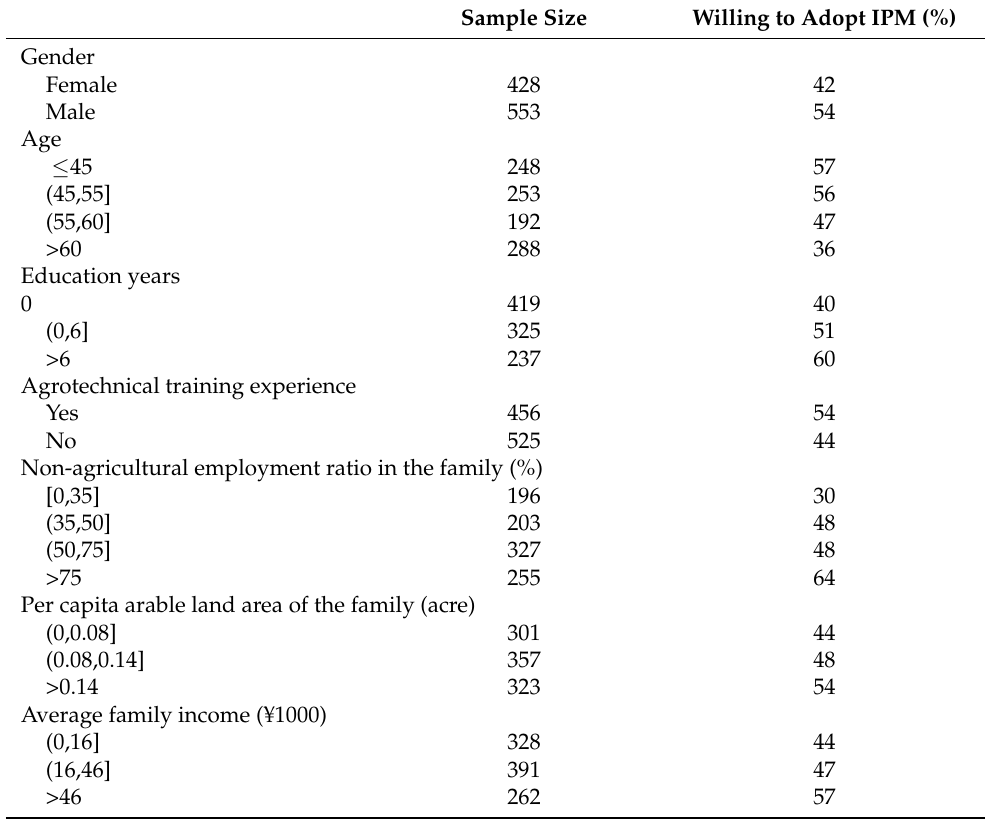
Table 5. The relationship between farmers’ demographic information/agricultural production expe- rience and willingness to adopt IPM